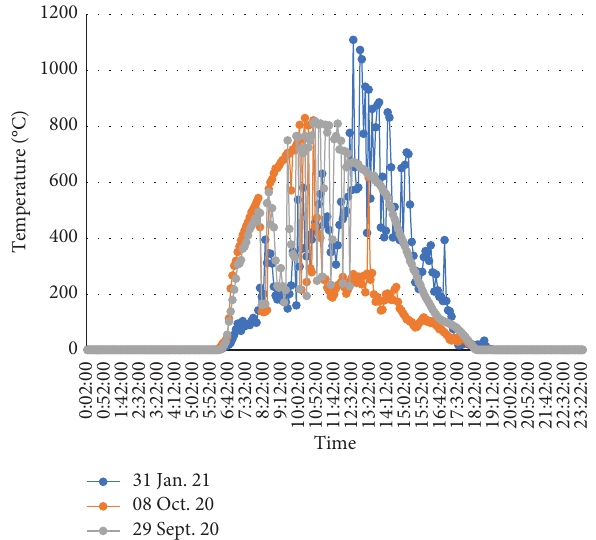
Figure 9: Solar radiation curves under moderate average daily solar radiation.